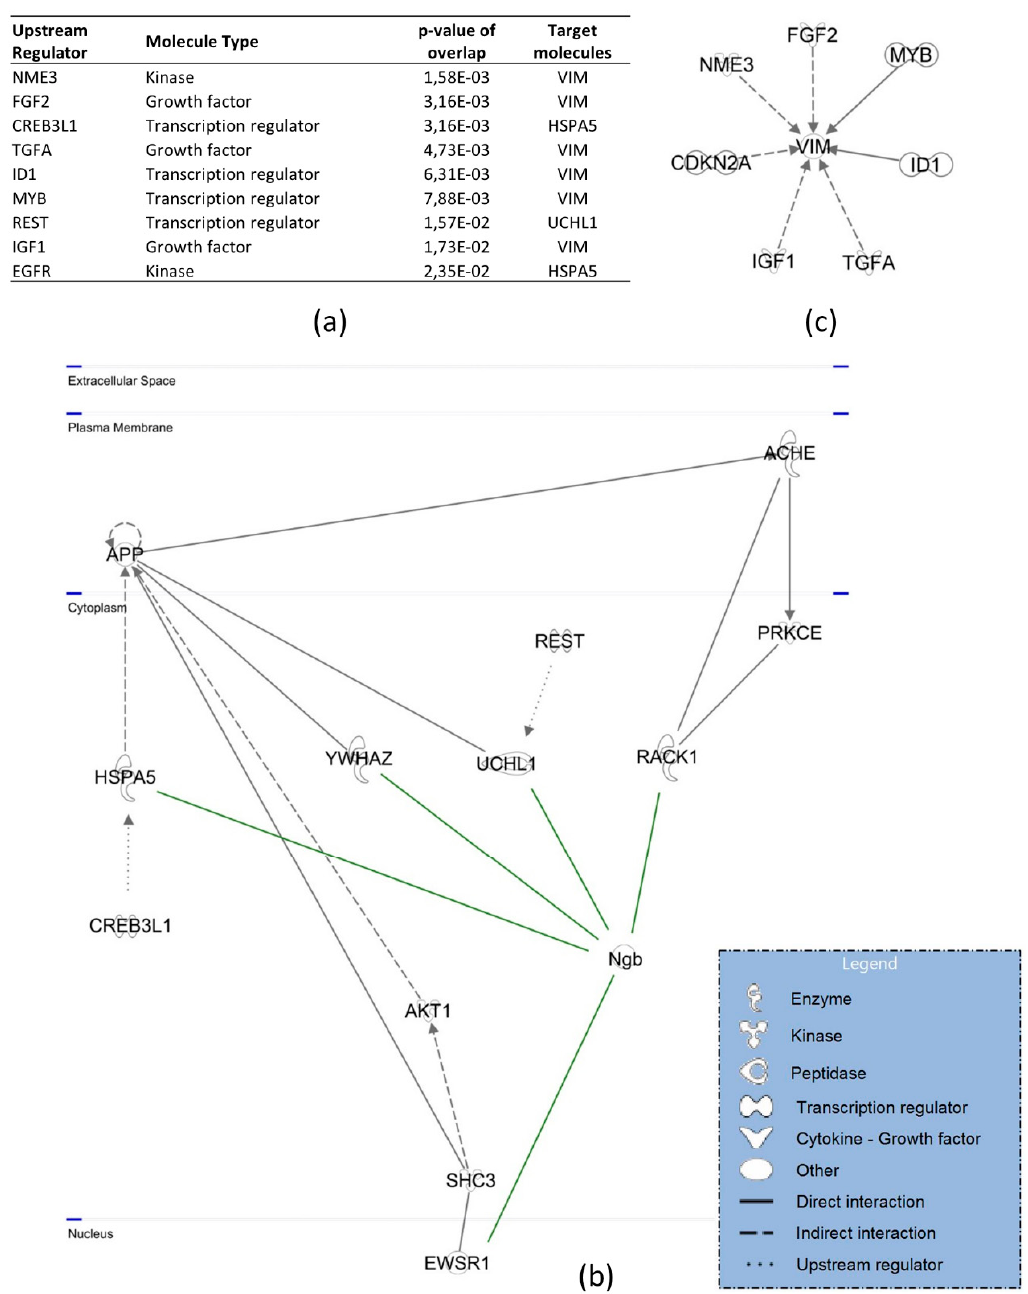
Figure 6. Upstream regulators and signaling cascades linked to the hNgb protein interactors in a non-stress condition. ( a ) The top predicted upstream regulators of hNgb-linked pathways: nucleoside diphosphate kinase 3 (NME3), fibroblast growth factor 2 (FGF2), cyclic AMP ‐ responsive element ‐ binding protein 3-like protein 1 (CREB3L1), transforming growth factor-alpha (TGFA), DNA-binding protein inhibitor ID-1 (ID1), transcriptional activator Myb (MYB), RE1-silencing transcription factor (REST), insulin-like growth factor I (IGF1), and epidermal growth factor receptor (EGFR). ( b ) The ‘cell